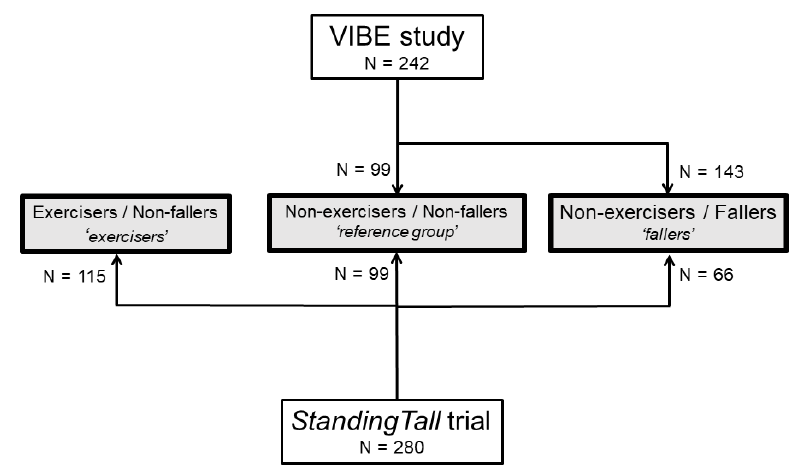
Figure 1. Overview of participants with available data in the VIBE cohort and StandingTall trial on group allocation.